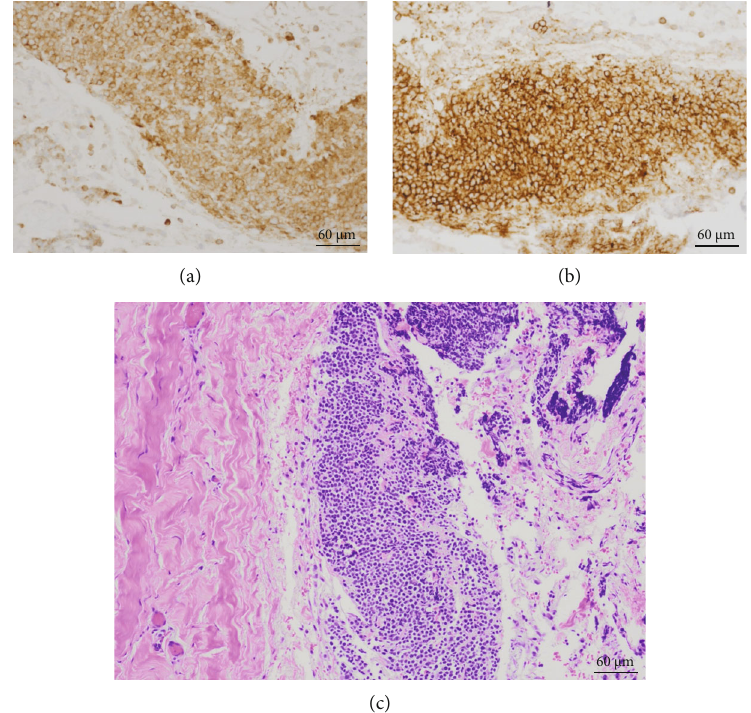
Figure 2: (a) Pericardial biopsy CD10+. (b) Pericardial biopsy CD19+. (c) Pericardial biopsy H&E